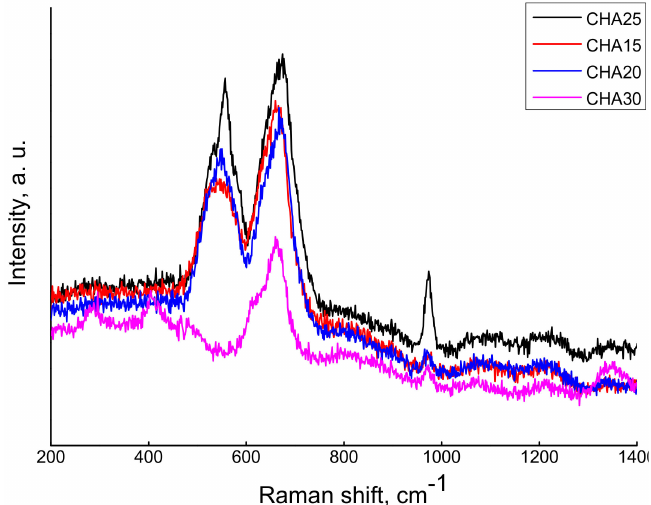
Figure 5. Raman spectra of the CHA samples containing 15, 20, 25, and 30 layers of Ca–P–O gel deposited on rough stainless-steel substrate in 200–1400 cm − 1 spectral